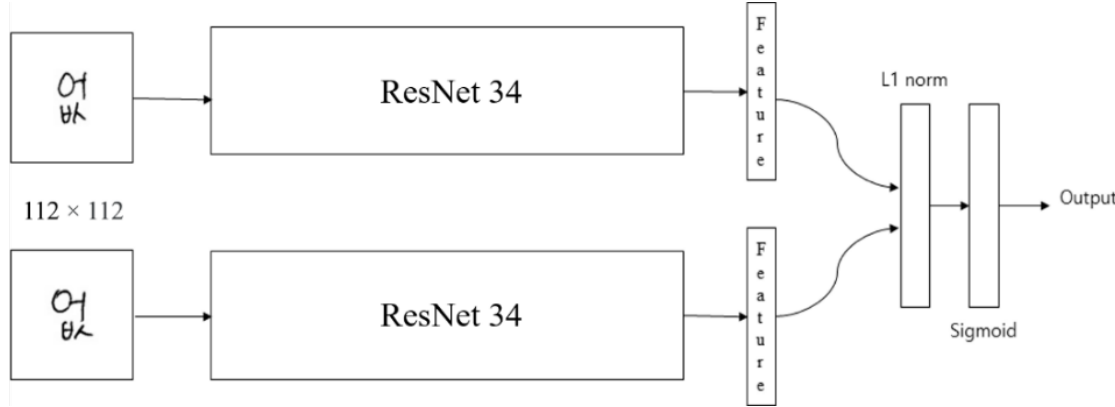
Figure 4. Siamese network structure.